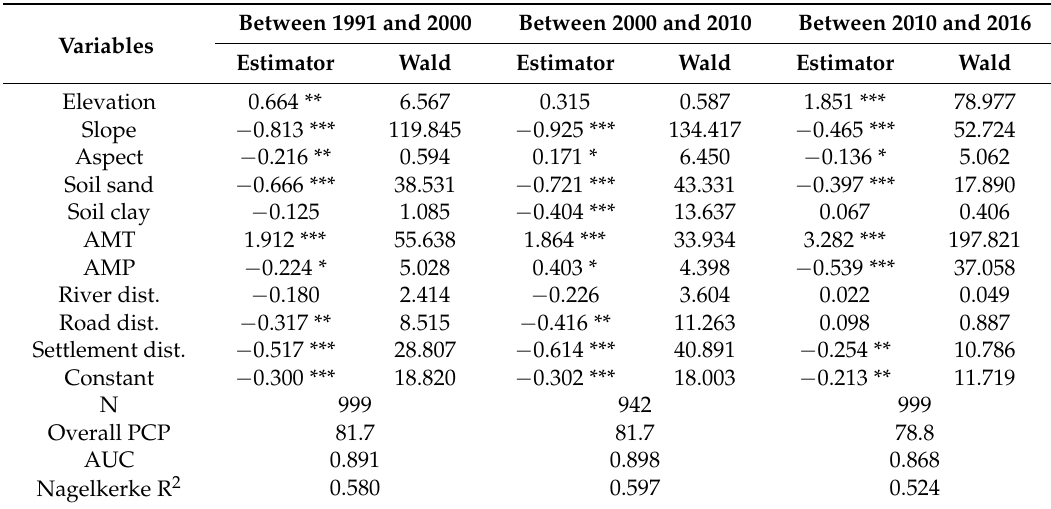
Table 6. Model estimations for the driving forces underlying farmland contractions within the Chinese TRB region. Between 1991 and 2000 Between 2000 and 2010 Between 2010 and 2016 Variables